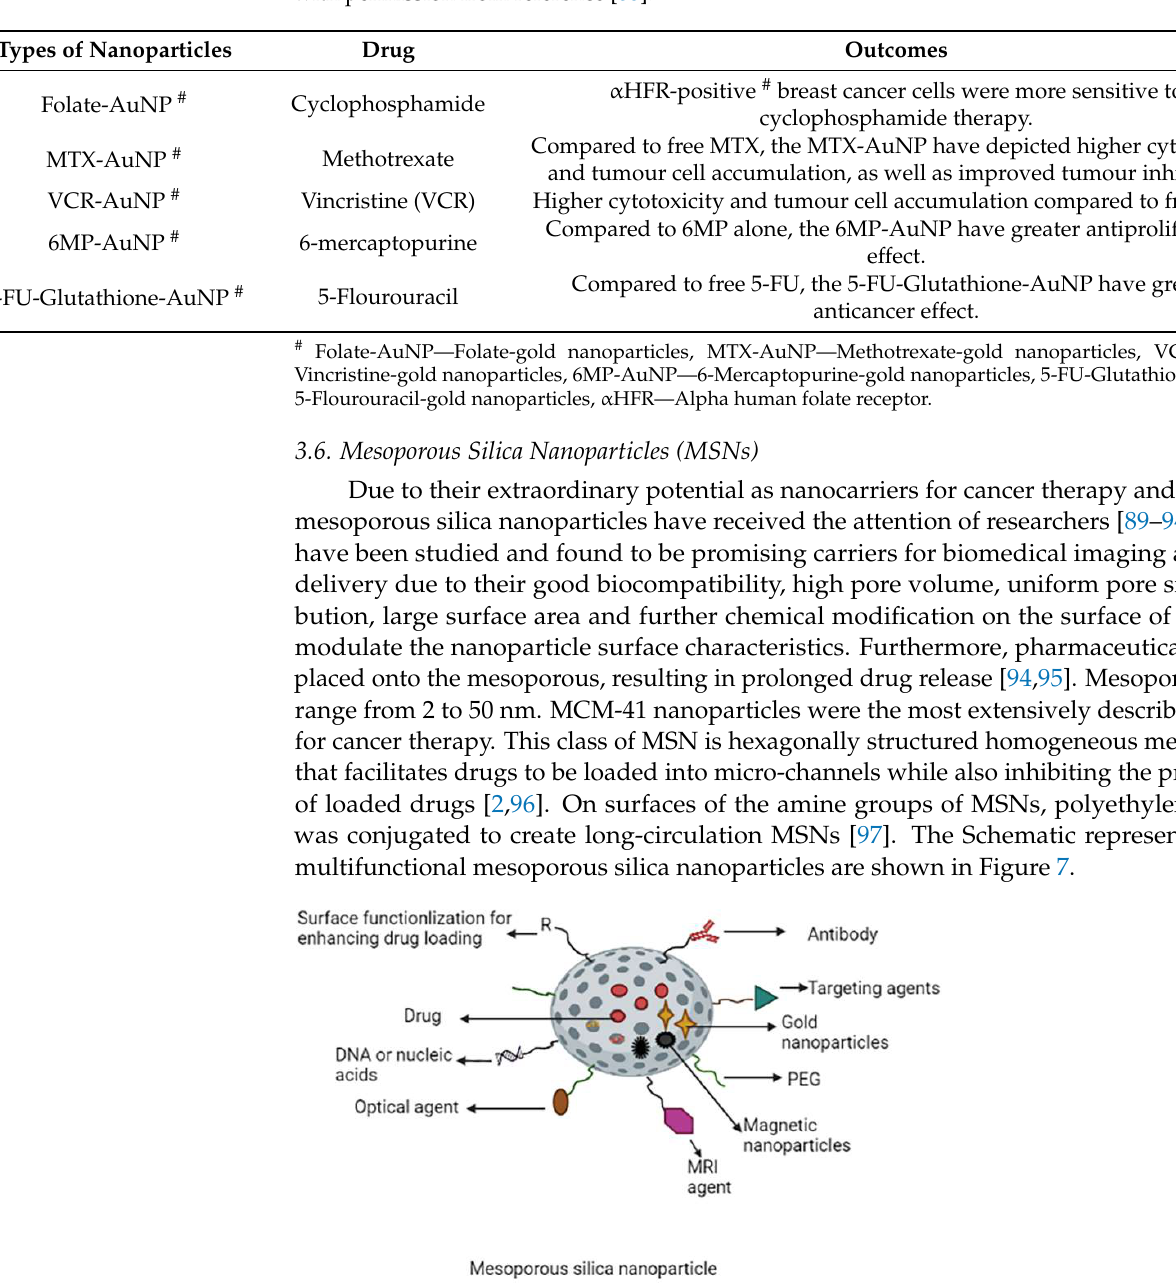
Figure 7. Schematic representation of multifunctional mesoporous silica